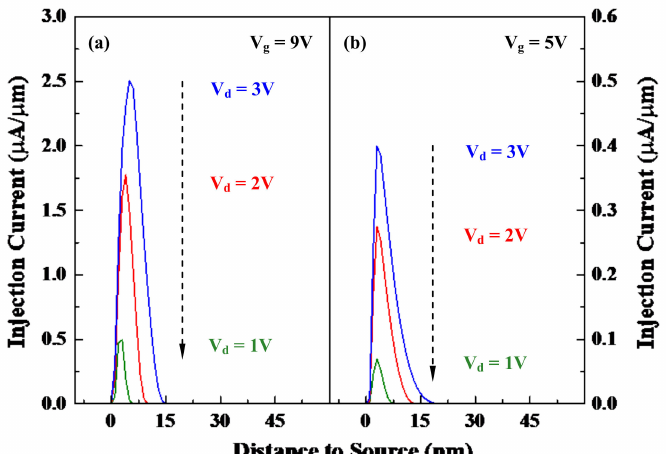
Figure 10. Distributions of electron injection currents in scaled double-gate Schottky barrier cells with various drain voltages at gate voltages of ( a ) V g = 9 V and ( b ) V g = 5 V. There are two di ff erent axis scales for the two conditions of gate voltages in the vertical